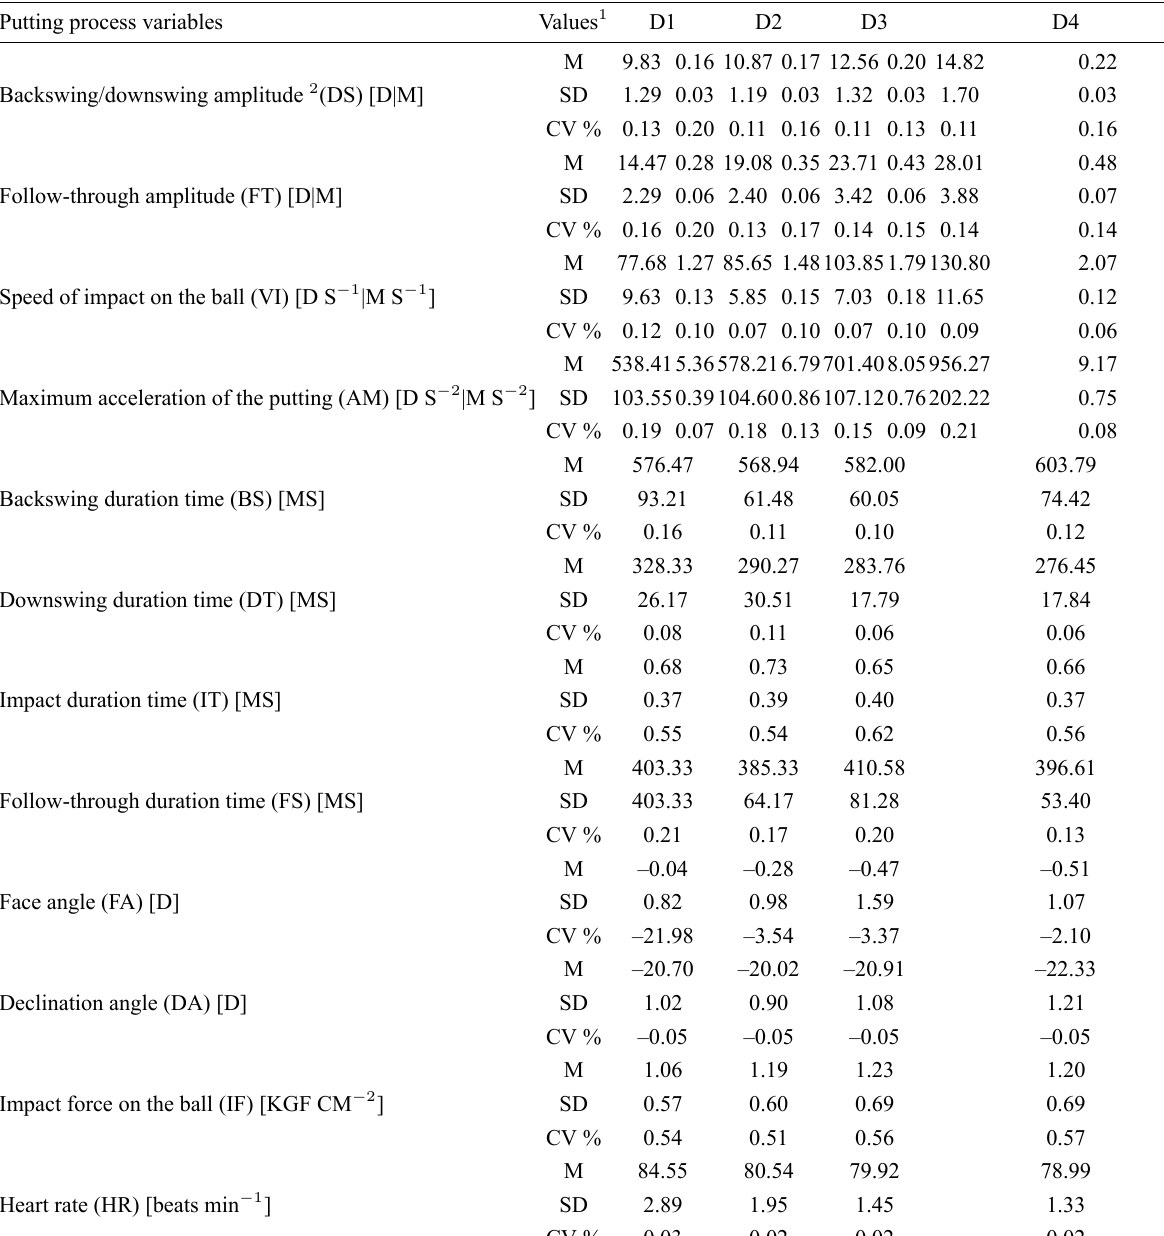
Table 1. Putting process variables.